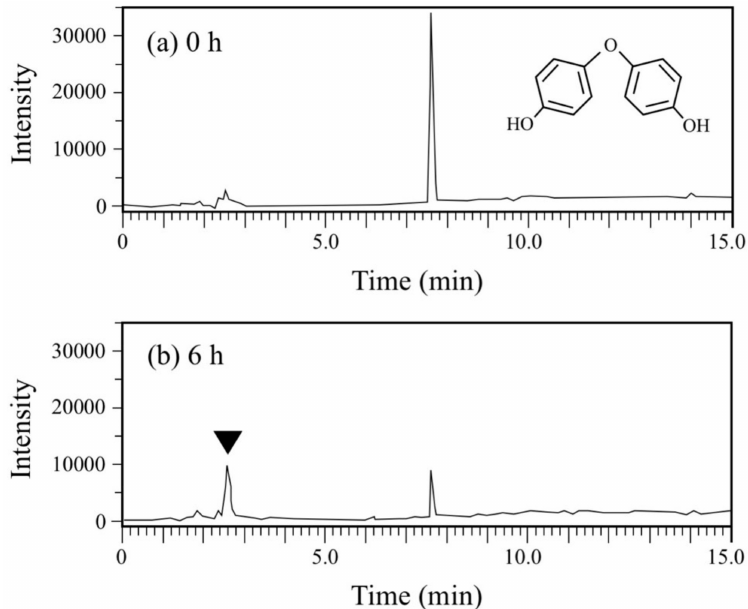
Figure 6. Chromatograms from HPLC analysis of the cell suspension samples of P. putida KT2440 harboring pBNMOA-F ( nmoA ) in the BPF degradation test. ( a ) Starting point (0 h), and ( b ) after 6-h incubation (6 h). An arrowhead shows a newly appeared peak in the degradation, which was later identified as HQ by GC / MS